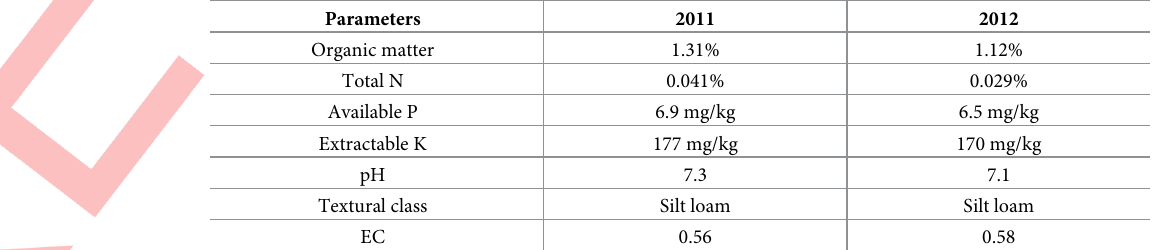
Table 1. Physico-chemical analysis of the soil samples from experimental